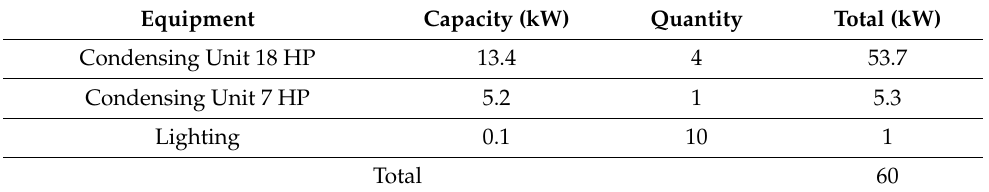
Table 2. Cold Storage’s Total Power